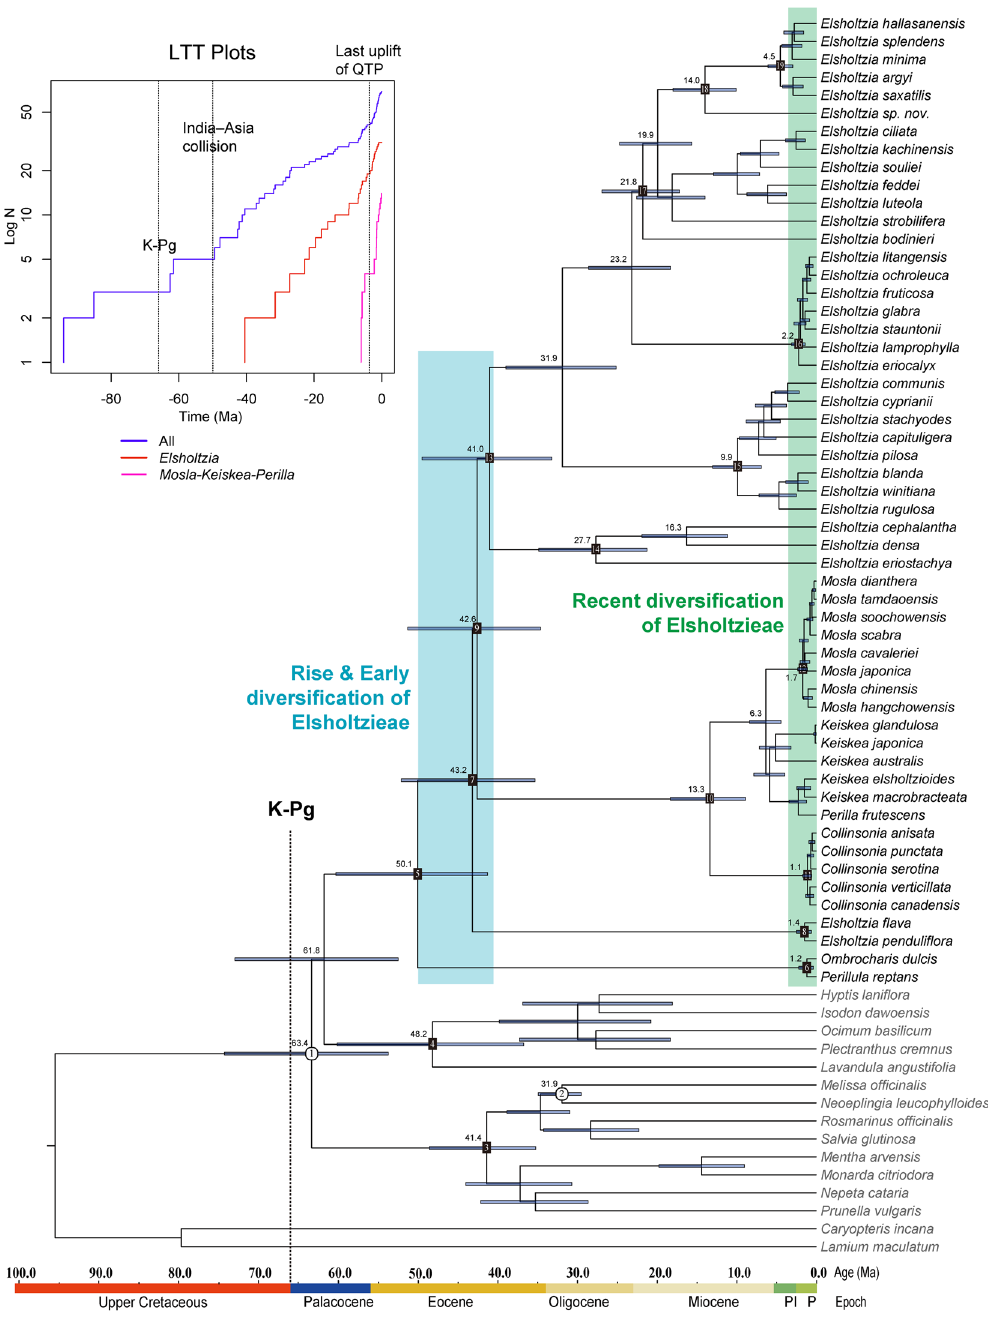
Figure 2. Phylogenetic chronogram of Elsholtzieae as inferred from beast analysis based on two calibration points (node 1 & node 2). Blue bars represent 95% highest posterior density of node age. Our results indicate that an early diversification of Elsholtzieae occurred in Middle Eocene after its rise in Early Eocene (blue shading), and a recent rapid diversification took place after the end of the Miocene (green shading). Standard LTT plots for Nepetoideae, Elsholtzia , and the Mosla-Keiskea-Perilla clade are presented in the upper